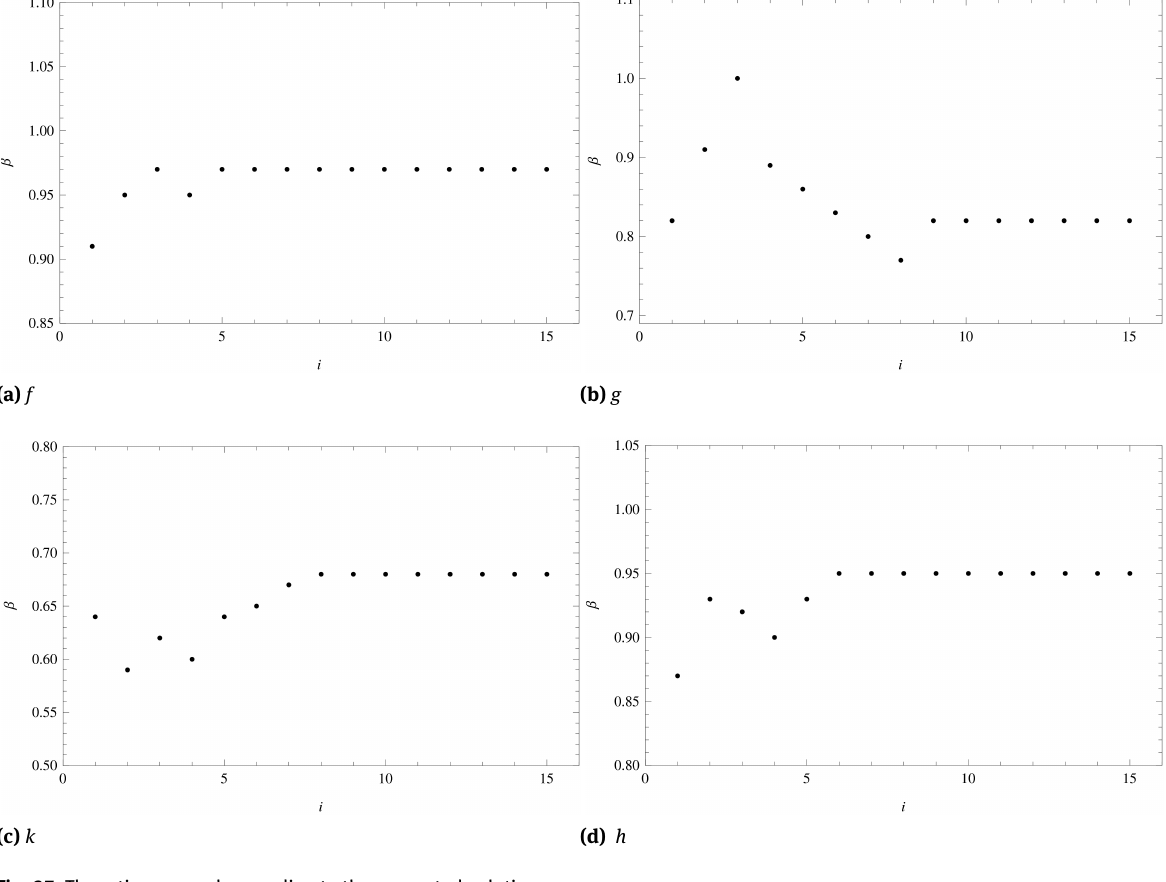
Fig. 27: The ratio approach regarding to the presented solutions